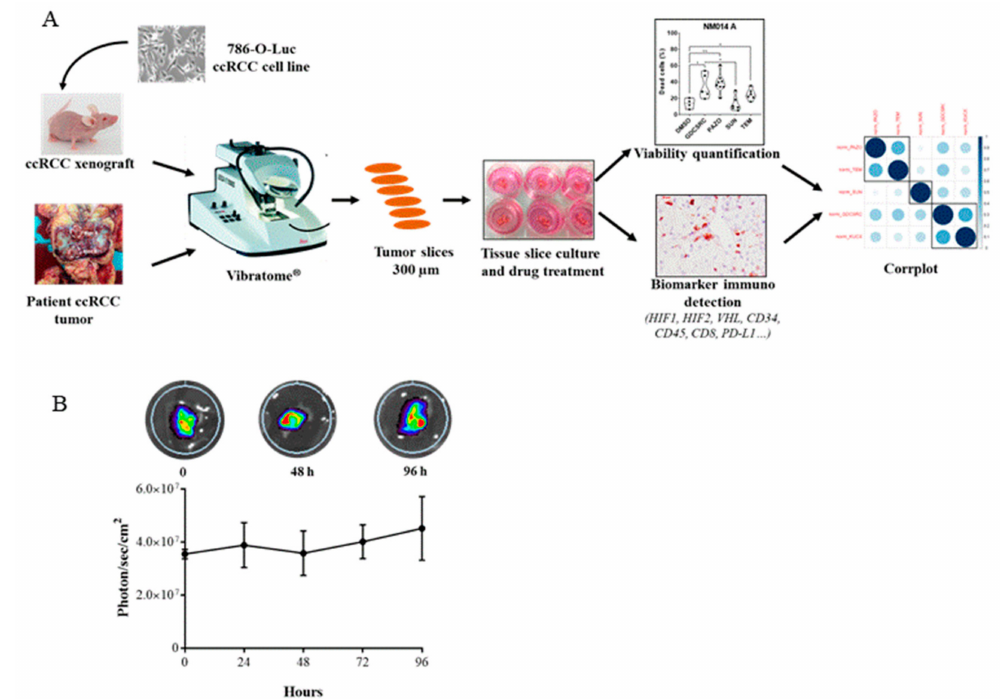
Figure 2. The procedure flowchart for renal tumor slice culture. ( A ) 786-O-derived tumors generated in mouse xenografts or human ccRCC surgical resection specimens are cut into 300 µ m slices in bu ff er solution using a Vibratome ® . The slices are transferred to culture medium and then carefully placed on membrane insert in 6-well plates to create an air-liquid interface. After 48 h of drug treatments, slices are analyzed for cell viability and biomarker immuno-detection. Correlation between drug sensitivity and biomarker expression is visualized with the graphical display of a correlation matrix (Corrplot, R package). ( B ) Tumor slices maintain cell survival over four days of culture. Slices from 786-O-luc-derived tumors were cultured for up to four days, with fresh media changes performed every two days. Each day, luminescence was recorded from slices after luciferin addition using IVIS imaging (upper panel). Plotted normalized photon quantification showed minimal changes over the culture